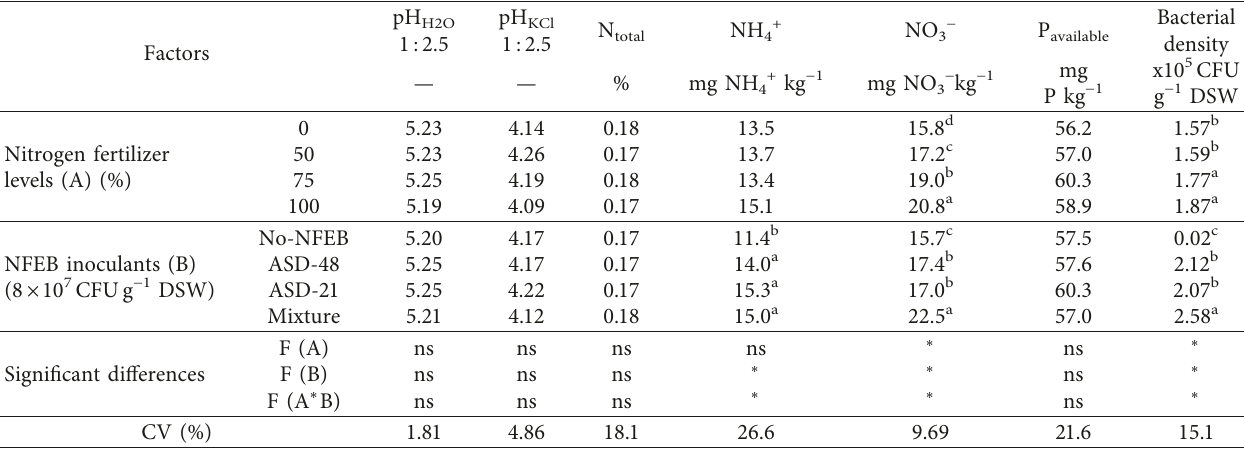
Table 2: Effects of nitrogen fertilizer levels and nitrogen fixing endophytic bacteria supplementation, Enterobacter spp., on improvement of alluvial soil fertility in dykes cultivated sesame at harvest.